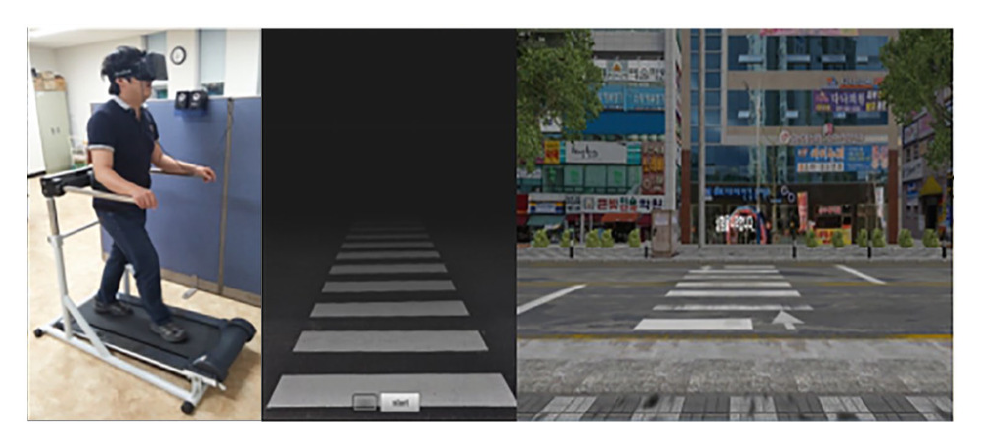
Figure 1. Images of experimental setup. Left panel: photograph of student participating in an experiment. Middle panel: cartoon crosswalk used for calibration. Right panel: Screenshot of the virtual crosswalk used in the experiment.